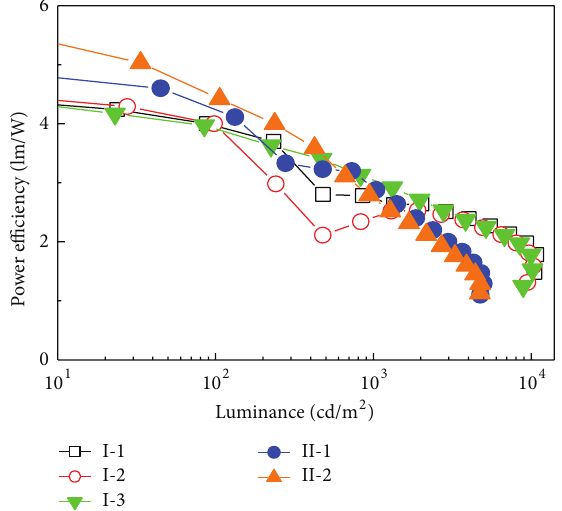
Figure 5: The resultant power efficiency of the sunlight-style OLED devices studied. For Device I-3 with the desirable color- temperature span and sunlight-style chromaticity, its power effi- ciency varied from 4.2 to 1.8 lm/W at luminance increasing from 10 to 10,160 cd/m 2